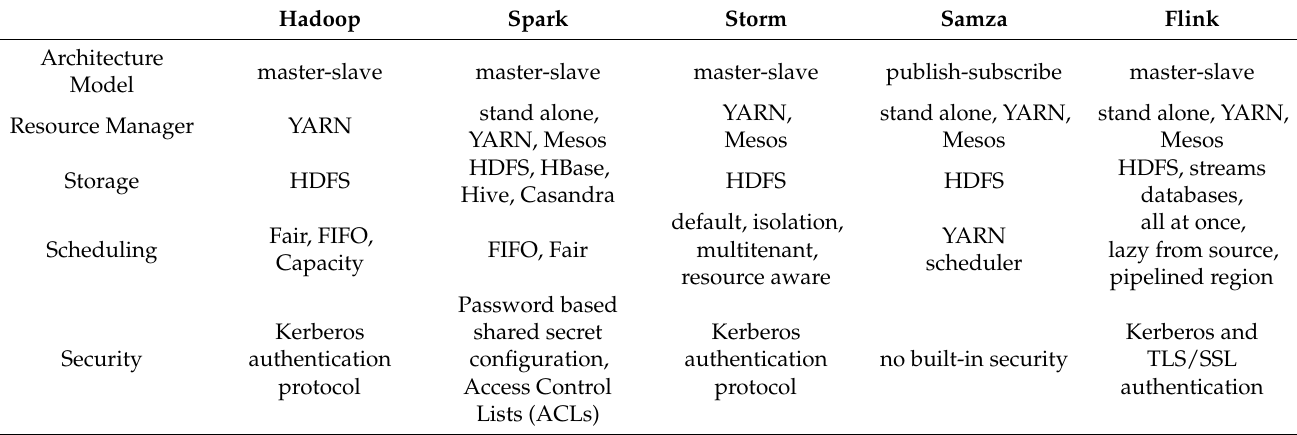
Table 4. Comparison of big data frameworks with respect to architectural features. Hadoop Spark Storm Samza Flink